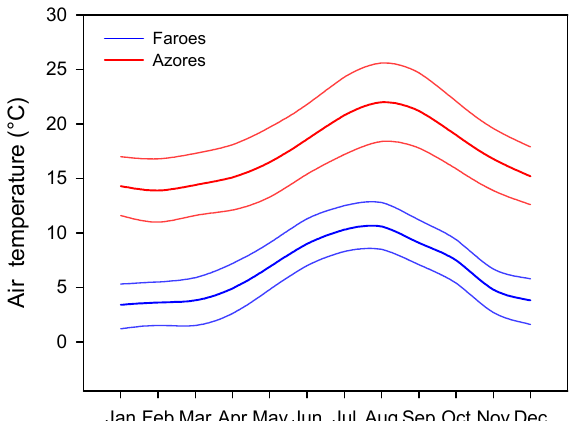
Figure 1. Average air temperature as full lines (average daily temperature per month) and maximum and minimum temperatures as dotted lines (average daily temperature per month) for Azores (red) and Faroe Islands (blue) during the period 1961–1990. Source: https://en.climate-data.org/europe/ (accessed on 13 May 2021).